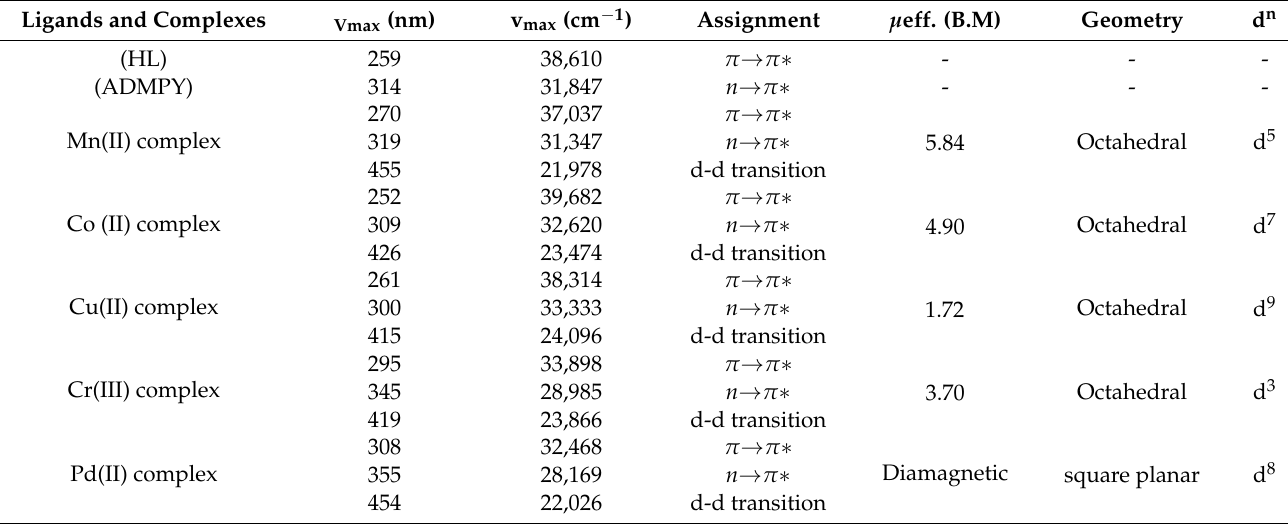
Table 2. Electronic spectral data of free ligand and its complexes and magnetic moments of the compounds.